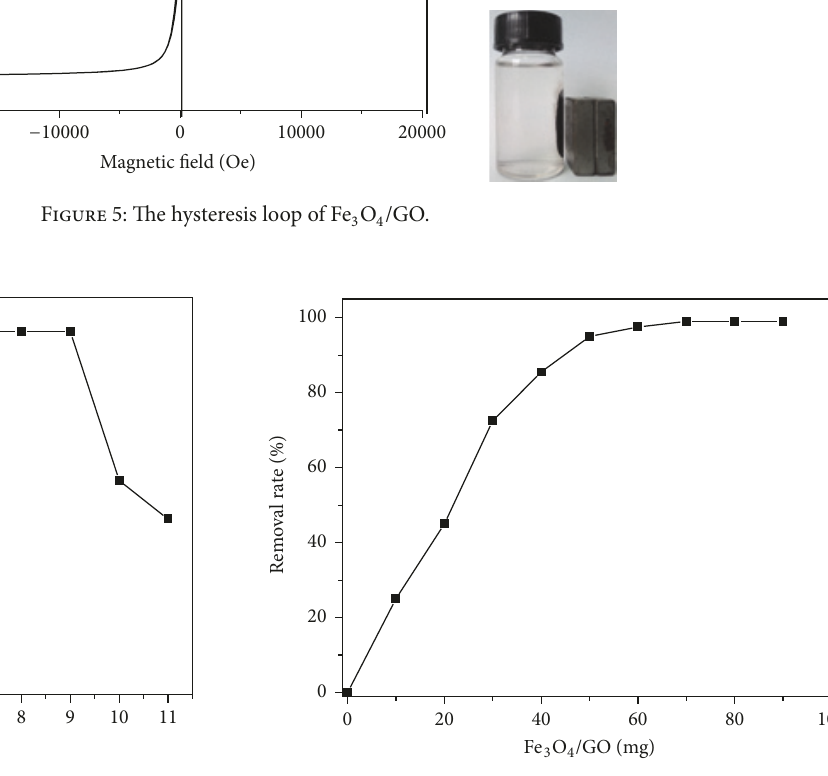
Figure 6: Effects of pH on adsorption efficiency of Sb(III). Figure 7: Effects of Fe 3 O 4 /GO dosage on removal efficiency of